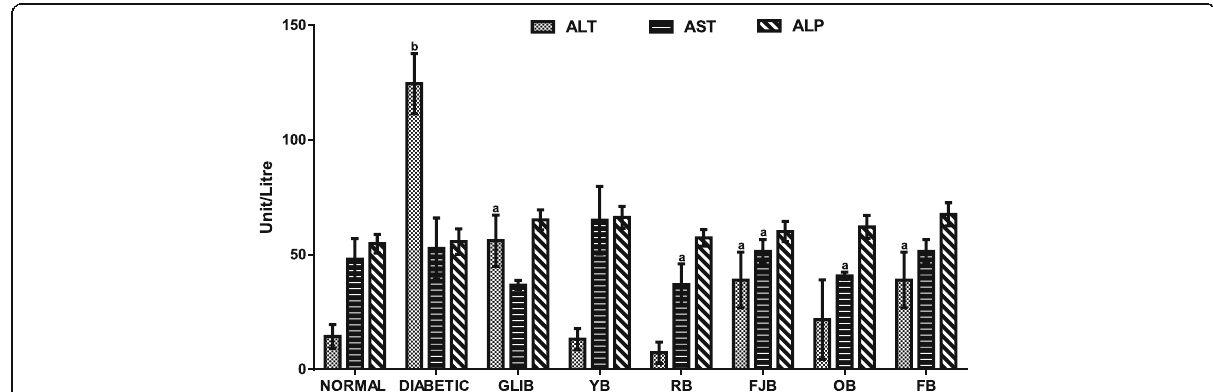
Fig. 4 effects of polyherbals on plasma ALT, AST and ALP levels in normal and diabetic rats. Results represented as Mean ± S.E.M. n = 6. a p < 0.05 or b < 0.001 different from control normal CMC group. c p < 0.05 or d < 0.001 different from control Untreated Diabetic group. CMC: Carboxylmethyl cellulose; YB: Yoyo bitters; RB: Ruzu bitters; FB: fajik bitters; OB: Oroki bitters; FB: Fidson bitters. ALT and AST: Alanine and aspartate aminotransferases; ALP: Alkaline